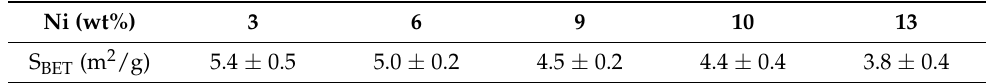
Table 1. Average catalyst surface BET as function of Ni-loading.